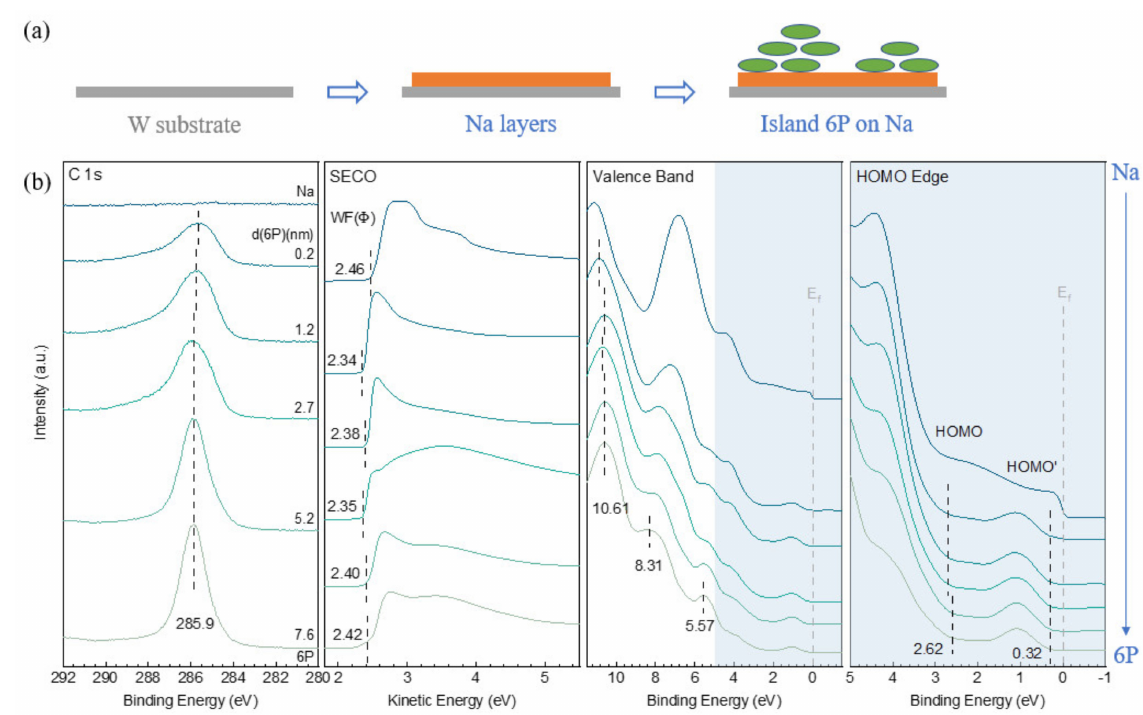
Figure 5. ( a ) Schematic of the 6P molecules and Na atoms deposition sequences. ( b ) XPS and UPS spectra of Na films with stepwise 6P deposition on a tungsten